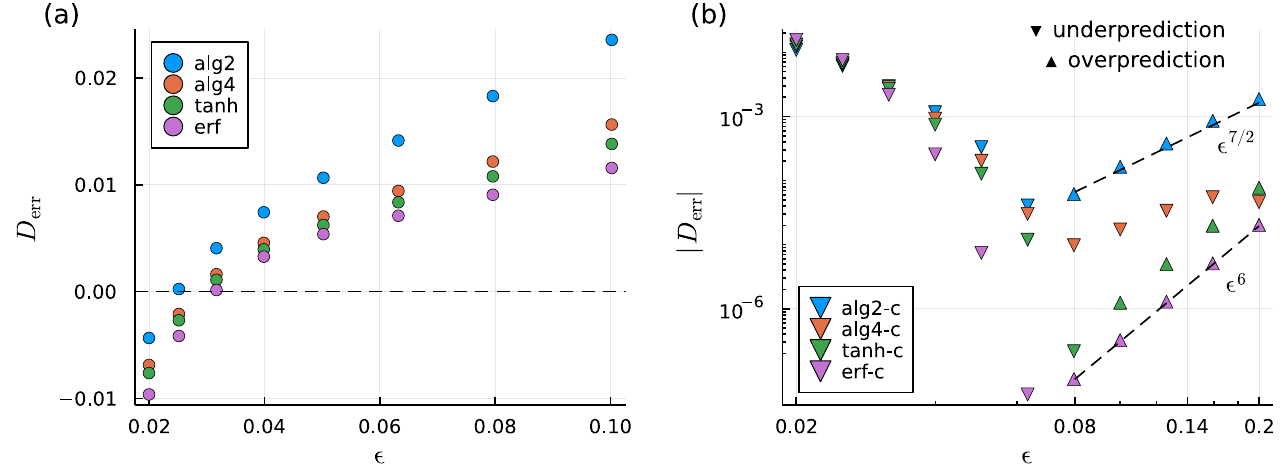
Figure 3. Similar to Figure 2, but for the corresponding inverse problem. Here, the error is the relative error with respect to the analytical result for the drag on the sphere, D err = D /6 π − 1, where D is the drag. Results for uncorrected and corrected smoothing factors are shown in ( a ) and ( b ), respectively. In ( b ), a log-log scale is used, and the absolute value of D err is plotted. We use ‘ (cid:72) ’s to indicate under-prediction ( D err < 0) and ‘ (cid:78) ’s to indicate drag over-prediction ( D err > 0). The dashed lines indicate the power-law scaling of D err in the regularization-error-dominated